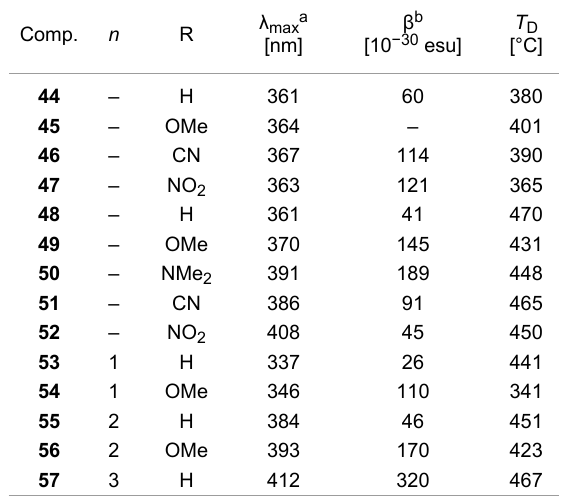
Table 8: Structure and properties of chromophore 44 – 57 [23,24,67].